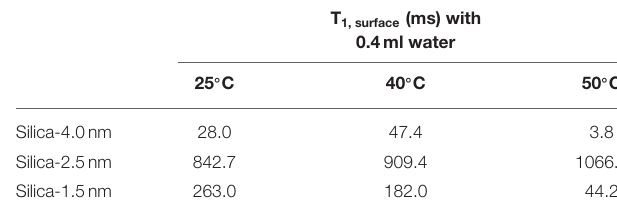
TABLE 7A | T 1,surface values of water in confined state.